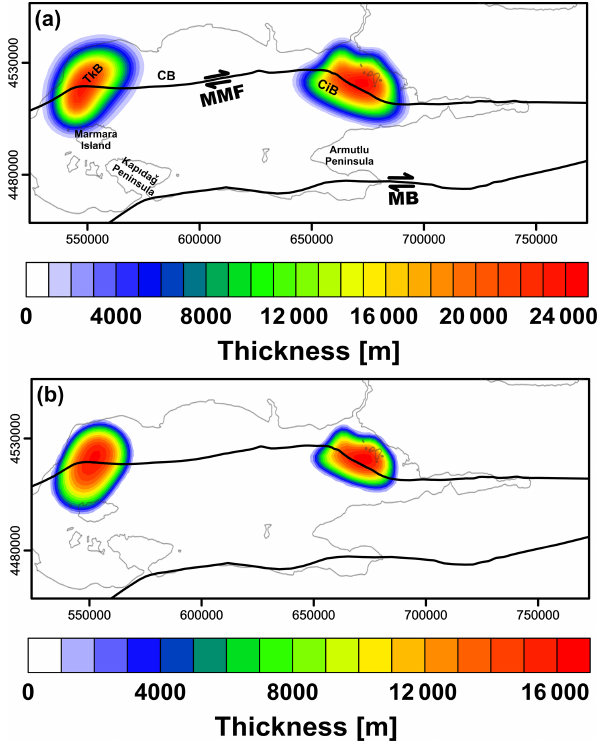
Figure 9. Thickness of the high-density bodies achieved from the forward gravity modeling. (a) This thickness map represents the high-density bodies that present the best fit with an average density of 3150kgm − 3 to EIGEN-6C4 (Model I) and of 2890kgm − 3 to Improved-TOPEX (Model III). (b) Thickness of high-density bod- ies with an average density of 3150kgm − 3 that shows the best-fit to Improved-TOPEX (Model